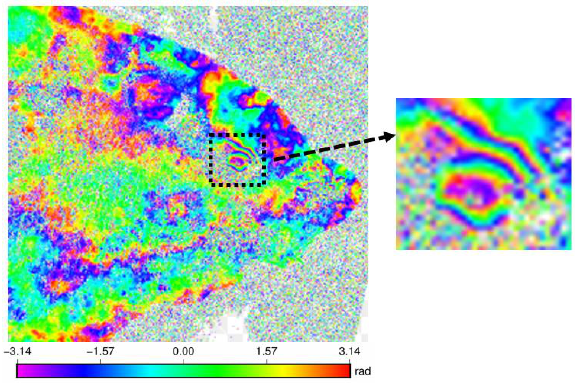
Figure 13. Sentinel 1A interferogram result